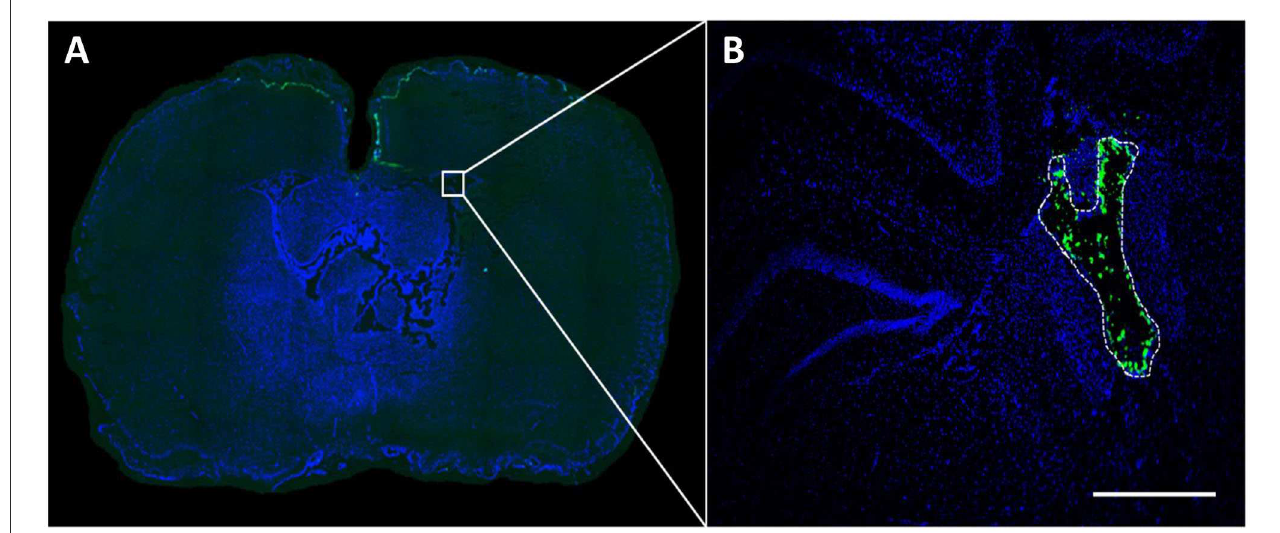
FIGURE1 NP fluorescence after intraventricular application. A volume of 10 µ l NP preparation (1,000 µ g/kg body weight) was injected into the right lateral ventricle and detectability of NP fluorescence was assessed in brain sections 1h after application. The green fluorescence signal (in this case corresponding to PLLA-SDS NPs) can be easily differentiated from the DAPI at bregma − 0.92 (A) . Microscopic magnification shows NP distribution within the lateral ventricle (B) . White bar indicates 100 µ m.